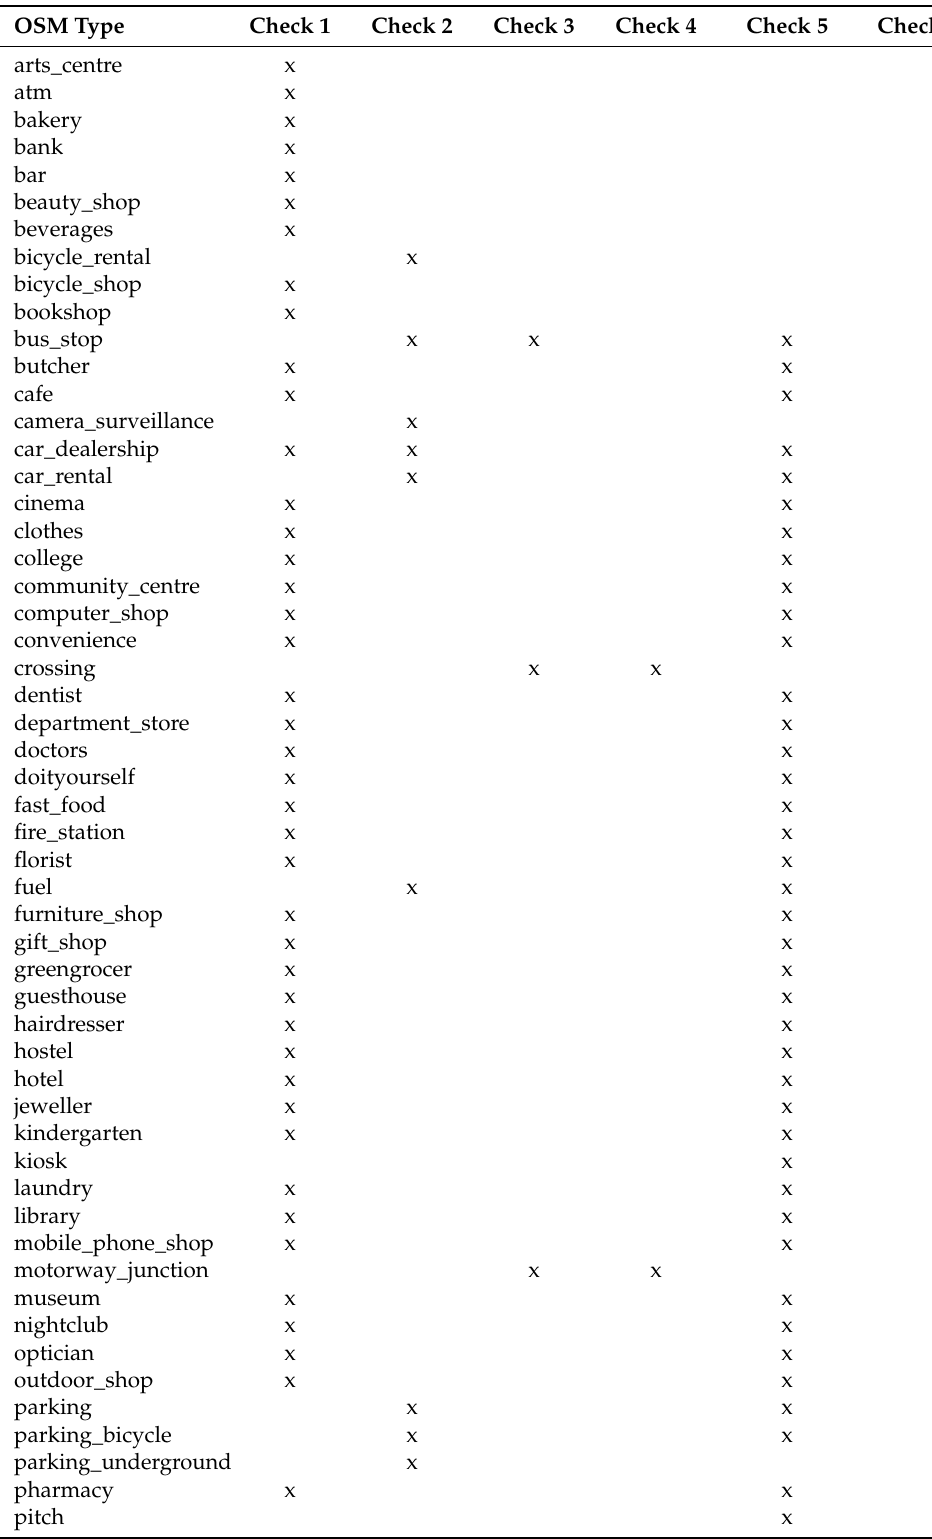
Table A1. Topo-semantic checks 1–6, which are applied to the POIs with specific “Type”